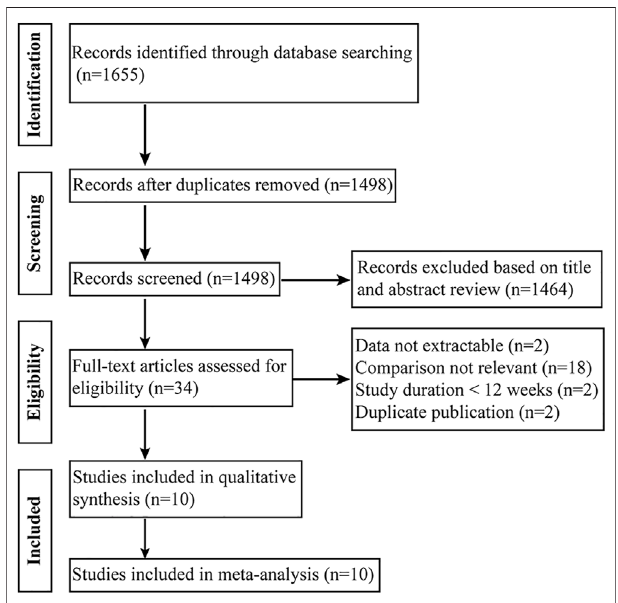
FIGURE 1 | Flowchart of study identi fi cation, inclusion, and exclusion.